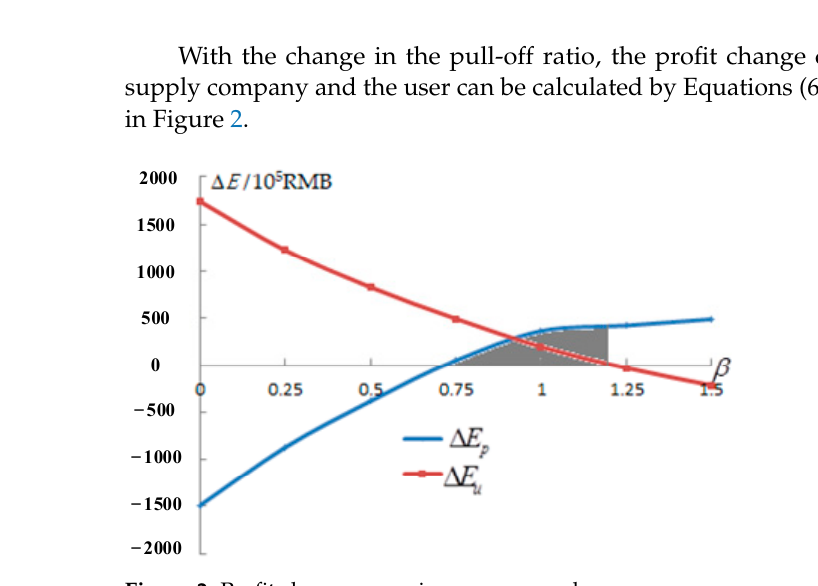
Figure 2. Profit change curve in company and user.